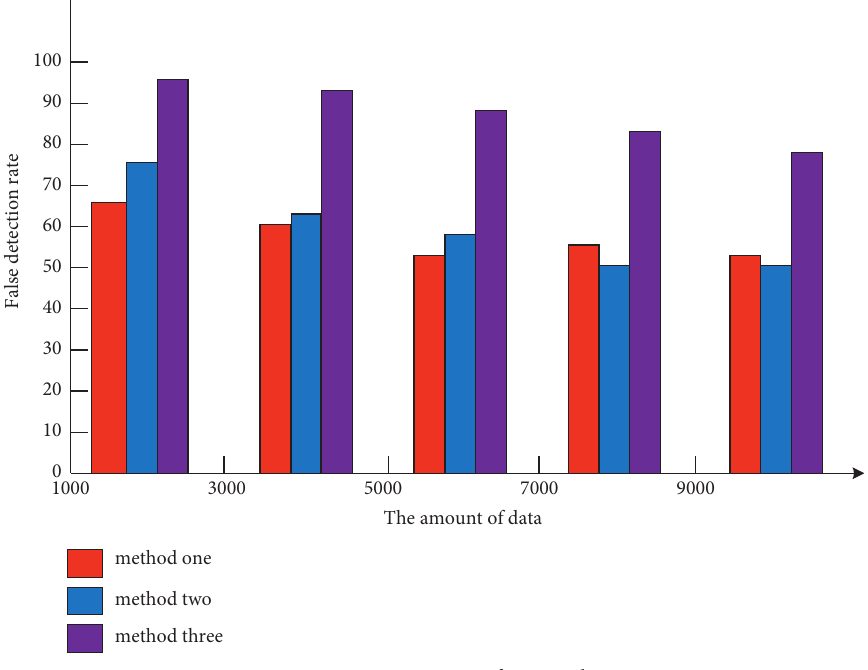
Figure 7: Detection rate of wrong